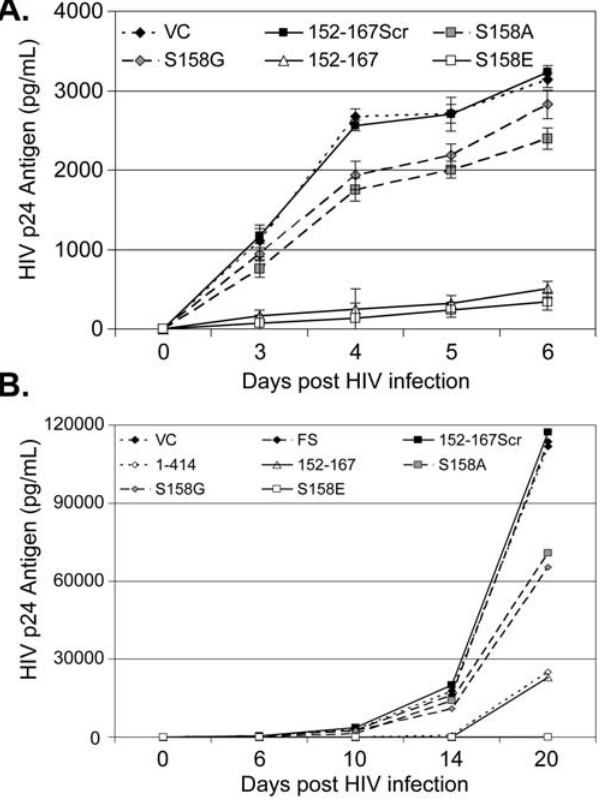
Figure 4. Expression of GBV-C NS5A peptides and HIV replication. To ensure that HIV inhibition was not due to abnormal- ities selected for during clonal selection of cell lines, HIV replication was assessed in the bulk cell lines that expressed the GBV-C NS5A 152–167 peptide, the scrambled peptide (152–167Scr), and the mutated peptides (S158A, S158G, S158E) and compared to the vector control cell line (VC) (panel A). The pattern of HIV inhibition did not change appreciably when infections were followed for up to 20 days (panel B). 1–414=cells expressing the full-length GBV-C NS5A and FS=cells expressing the GBV-C NS5A frame shift